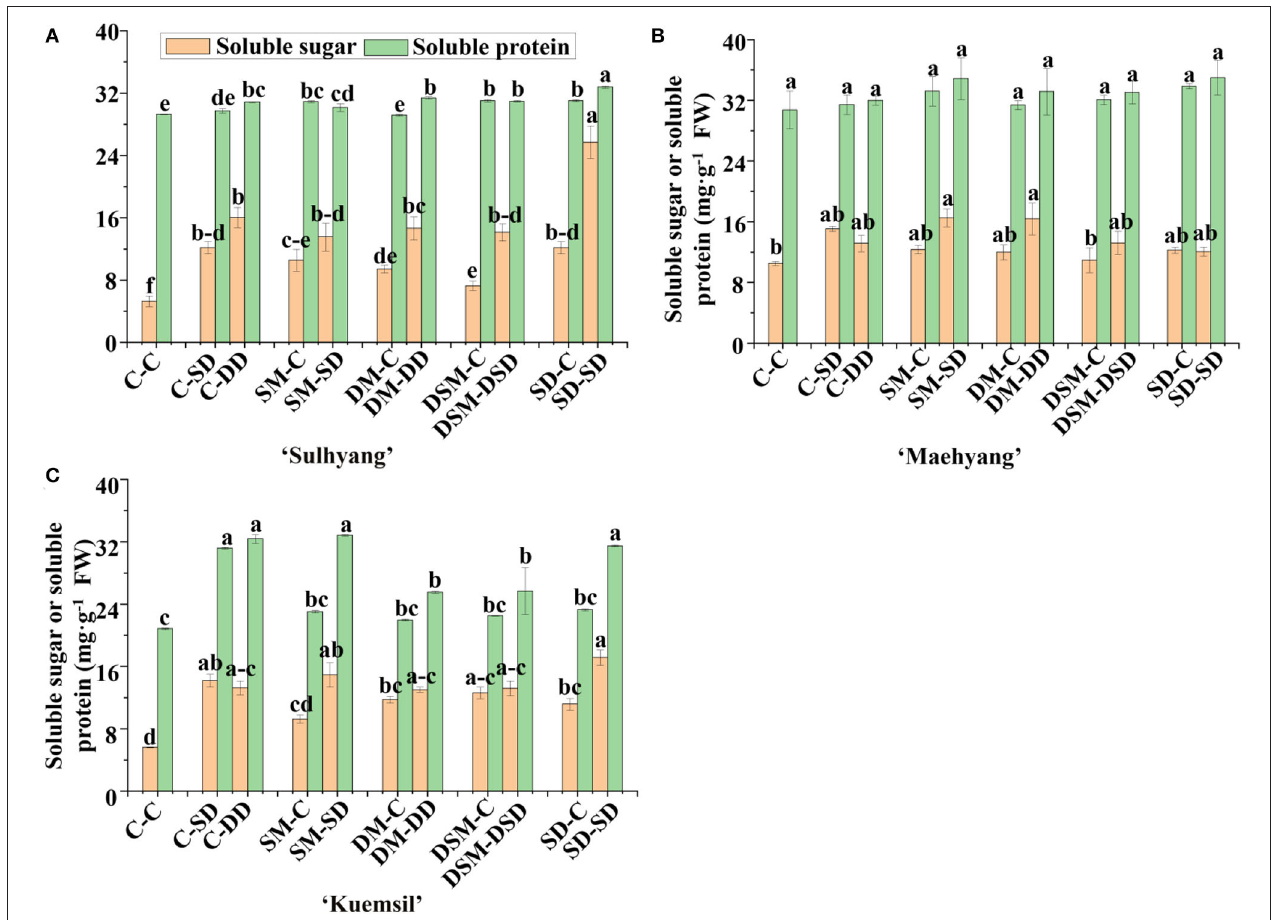
FIGURE 7 | Soluble sugar and protein contents in leaves of strawberry transplants (A) “Sulhyang”; (B) “Maehyang”; and (C) “Kuemsil” as affected by the Si treatment after subjection to 43 ◦ C for 7 days. Lowercase letters indicate significant differences calculated by the Duncan’s multiple range test at p ≤ 0.05. See Figure 1 for descriptions of treatment